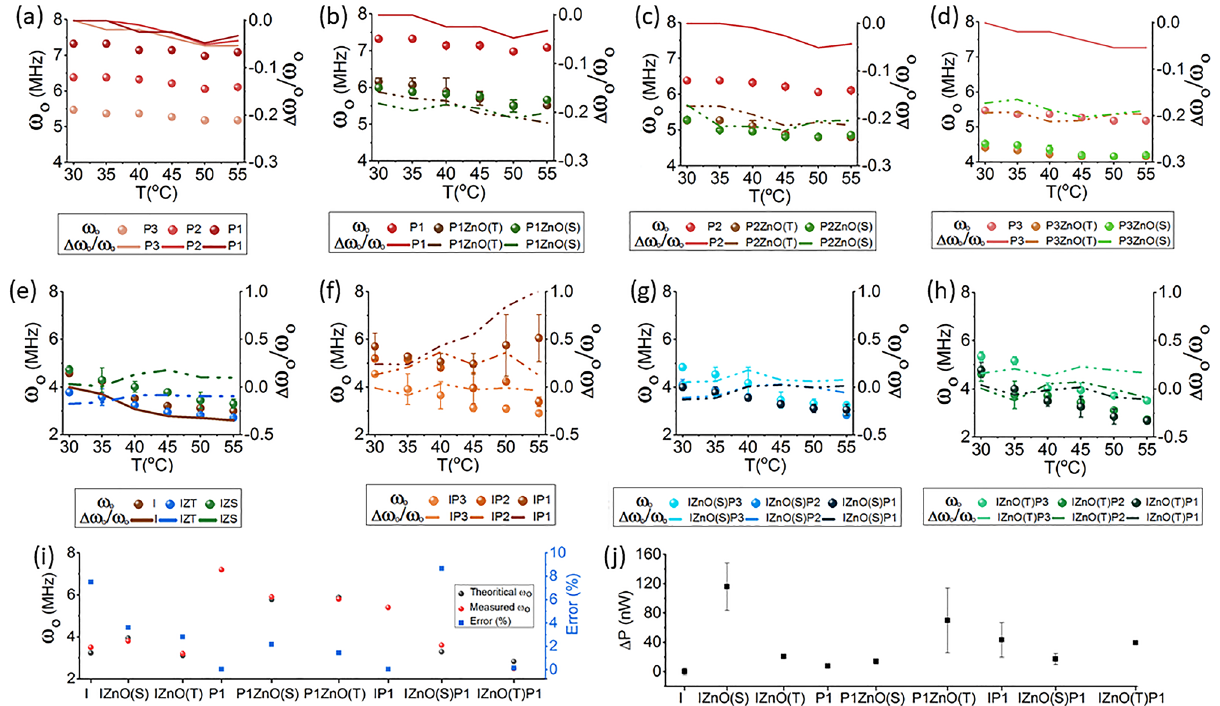
Figure 2. Theoretically proposed Mechanical Frequency (ω o ) of ( a ) Papain of three dilutions ( b – d ) and mixed with ZnO(S) and ZnO(T) ( e ) Insulin and Insulin mixed with ZnO(S) and ZnO(T) ( f ) Insulin mixed with three different dilutions of papain ( g ) Insulin mixed with ZnO(S) and Papain. ( h ) Insulin mixed with ZnO(T) and Papain (Here the average of theoretical mechanical frequency is plotted. Where the bar shows two runs executed as in case of dielectric constant) ( i ) Measured and Theoretical mechanical frequency using Spectroscopic technique and theoretical proposed model respectively and the corresponding relative error with the theoretical (Here the value corresponding to 45 °C and the case at 50 °C discussed in Supplementary file 2) ( j ) the Average power changed of sample, the Experiment was performed twice. So, the bars indicate the variation of two